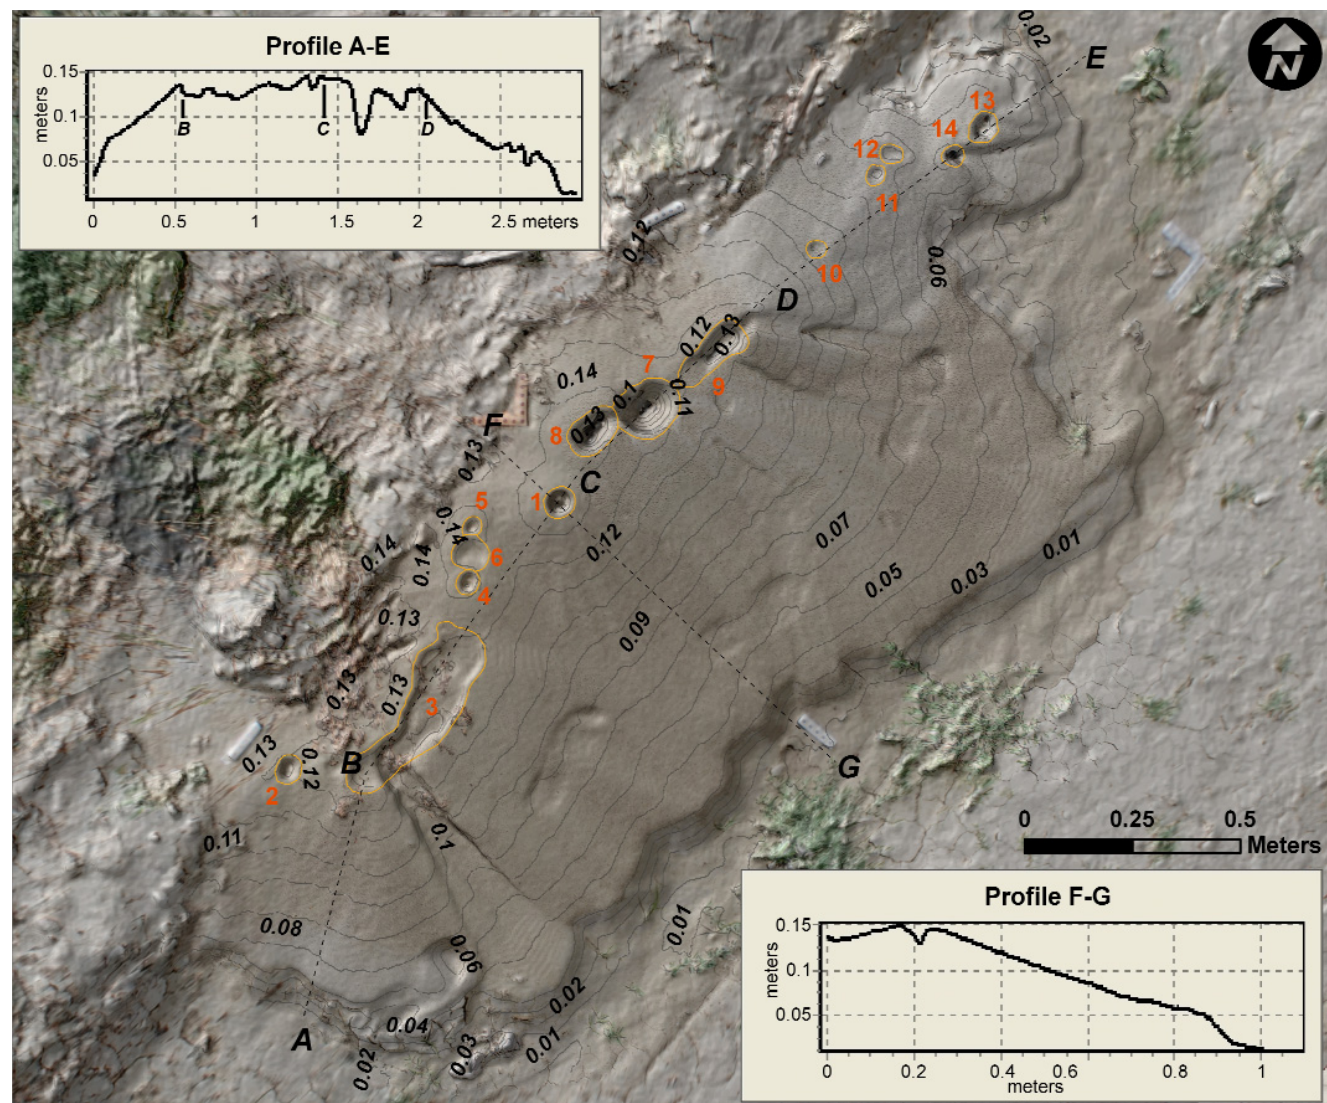
Figure 4. Orthophotograph draped over a shaded relief derived from the sand volcano DEM (cell size, 1 mm) that was reconstructed using a dataset of about 560 million pixels. Black dashed lines, profiles (A-E and F-G); gray lines, contour lines with 1-cm spacing. The limits of the individual emission points are highlighted in orange and numbered. The full dataset is north oriented and projected using a plane projection in a local metric coordinate